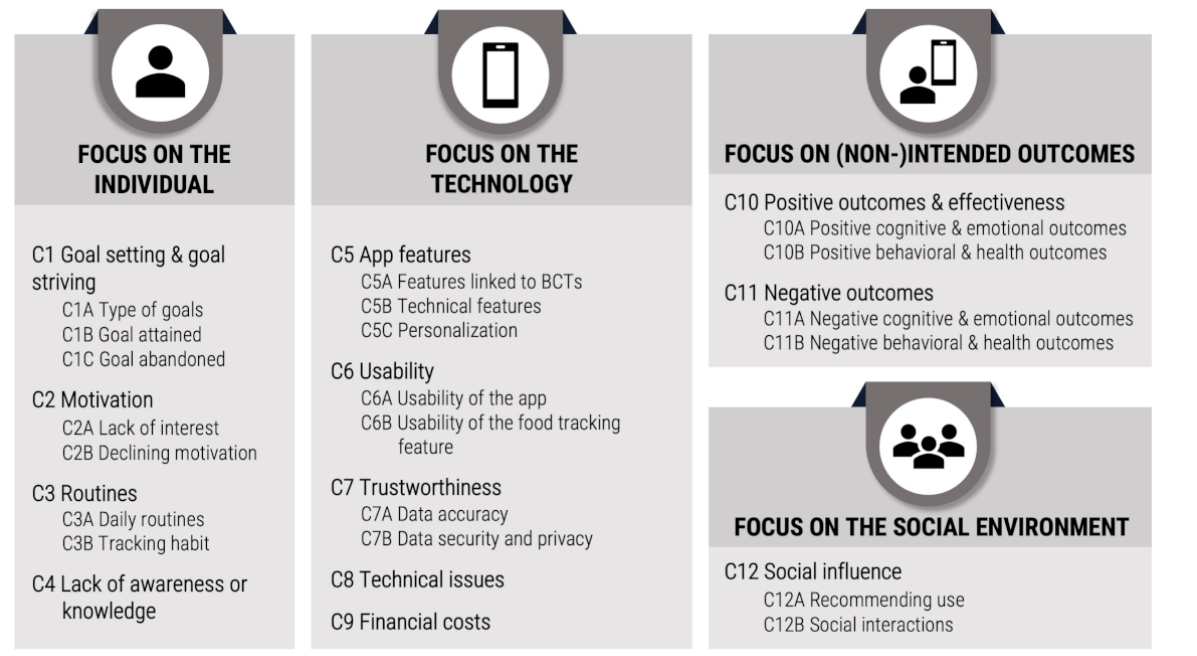
Figure 2. Framework comprising 12 categories C1-C12 and respective subcategories of barriers and facilitators identified in the individual studies. BCTs: behavior change